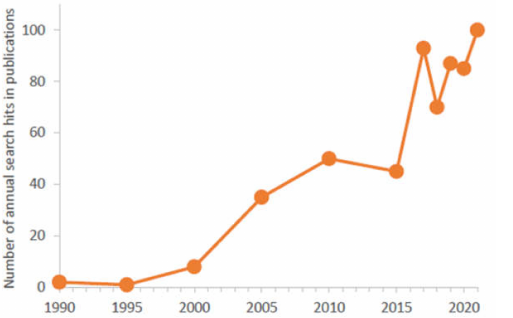
Figure 2. Number of annual search hits related to “MICROFLUIDIC ENZYME REACTOR” (searching with Google Scholar) where the keywords appeared in the articles. Table 1. Recent reviews of immobilized enzymatic reactors (2017–2021).